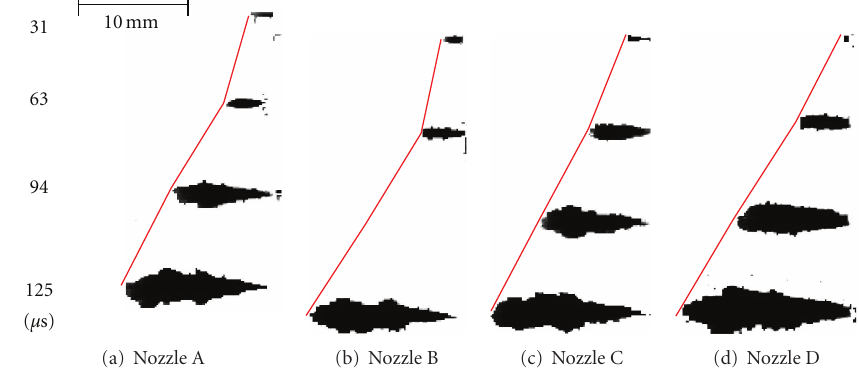
Figure 8: Initial stages of spray evolution for di ff erent nozzle types (experimental conditions: 1.5 ms injection duration, 50 MPa injection pressure, 3 MPa ambient pressure, and 300 K ambient